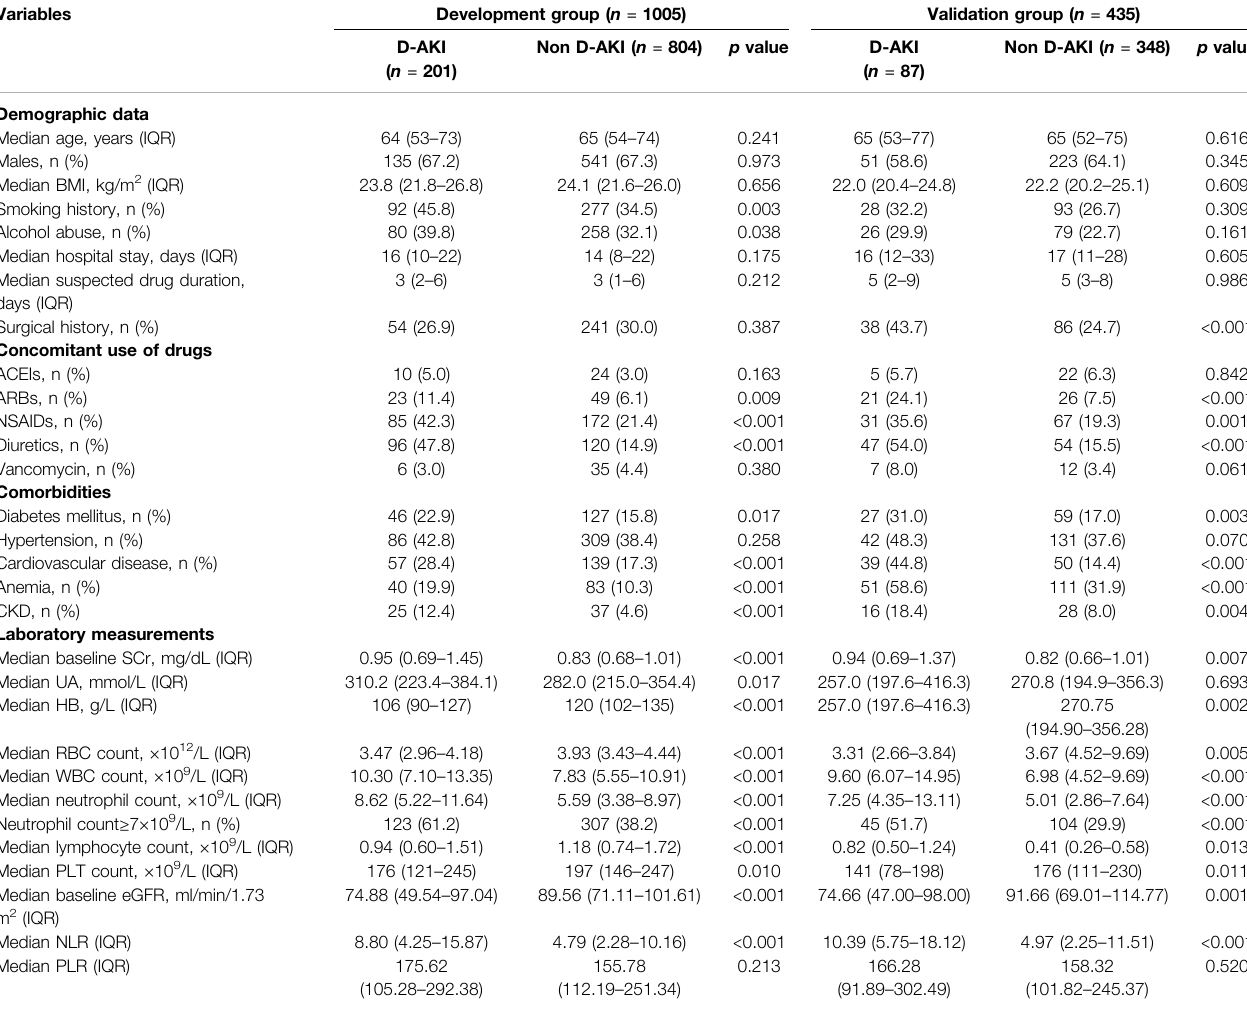
TABLE 2 | Baseline characteristics in the development and validation